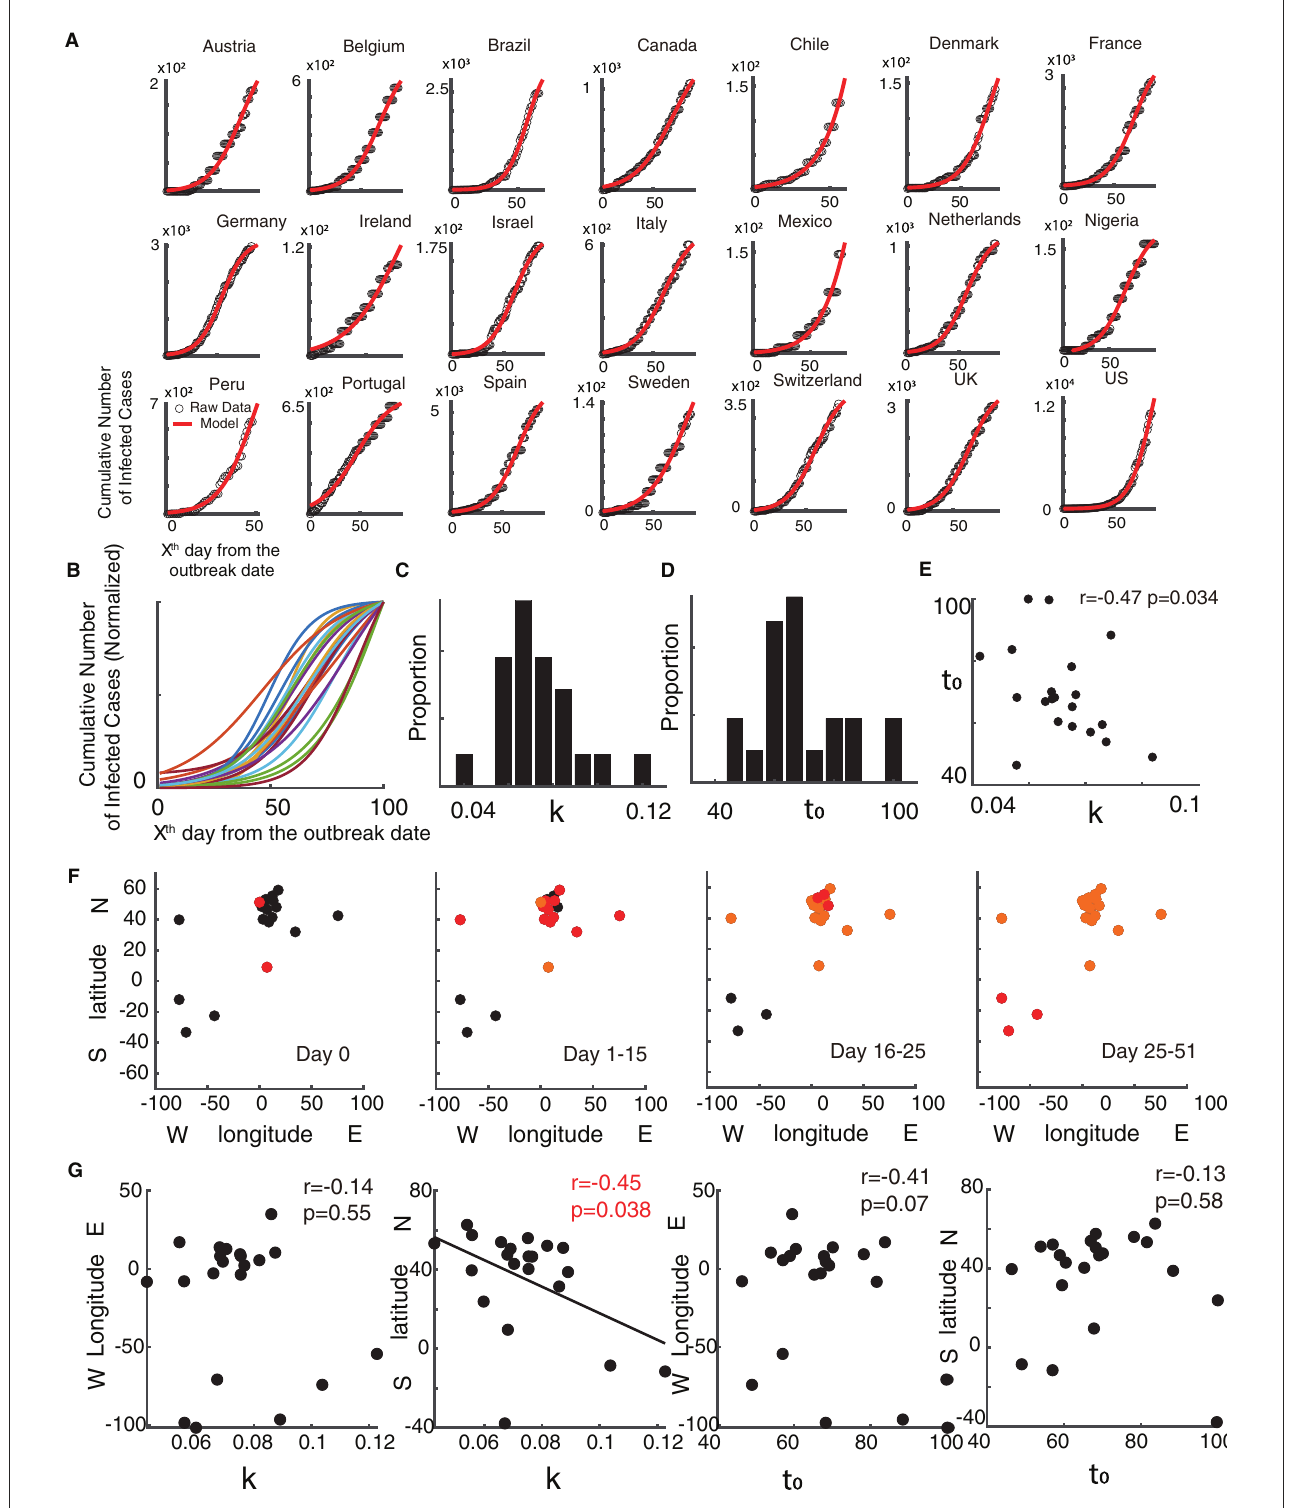
FIGURE1 Temporal dynamics of the monkeypox epidemic. (A) Raw data of the cumulative infected cases of monkeypox is shown in black dots and the fitted curve of the model is shown in red. (B) Normalized fitted curves of model for 21 countries. (C) Distribution of growth rate (k). (D) Distribution of semi-saturation period (t 0 ). (E) Relationship between growth rate (k) and semi-saturation period (t 0 ). (F) Spatial location of 21 countries and the development of the spread in four stages (Day 0, Day 1–15, Day 16–25, Day 26–51). The red dots are new outbreak countries in the current stage, the orange dots show countries where the virus is endemic, and the black dots indicate countries that have not experienced the epidemic. (G) Relationship between the spatial location (geodetic centroid) with the model parameters [growth rate (k) and semi-saturation period (t 0